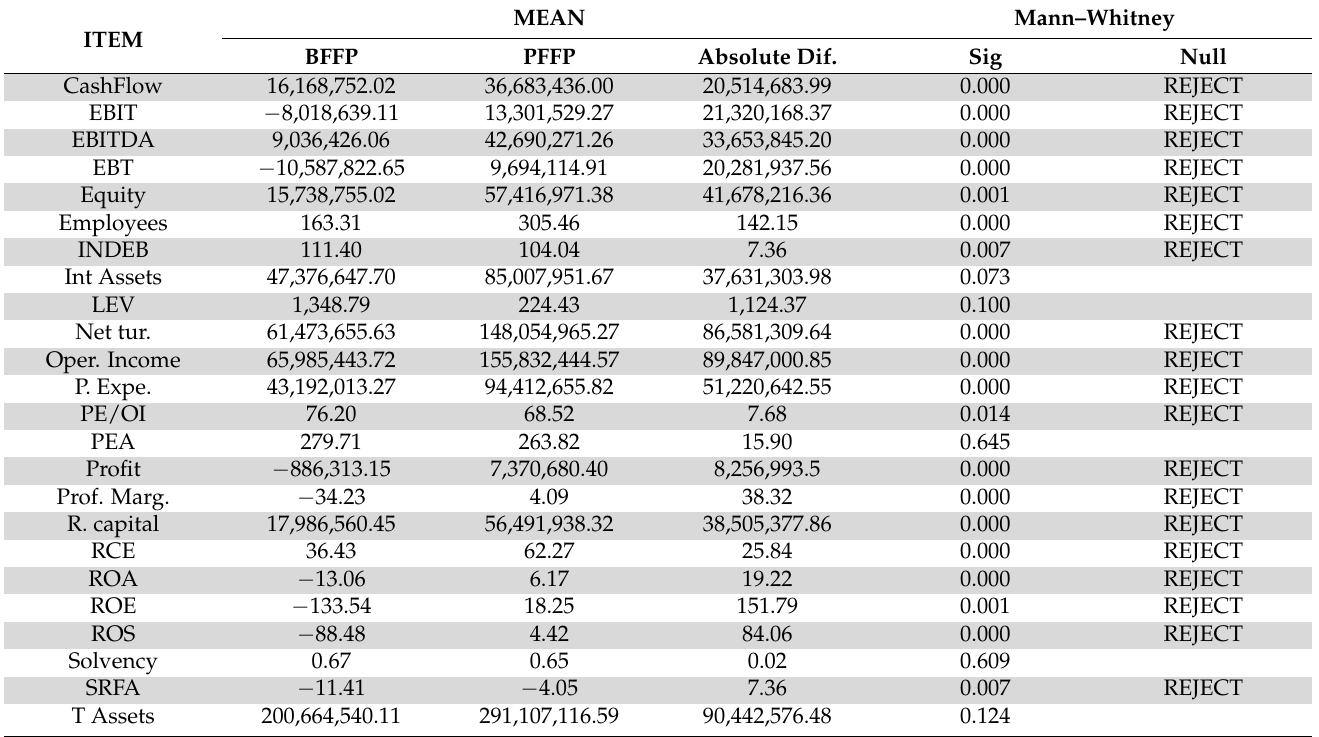
Table 1. Comparing variables before and post